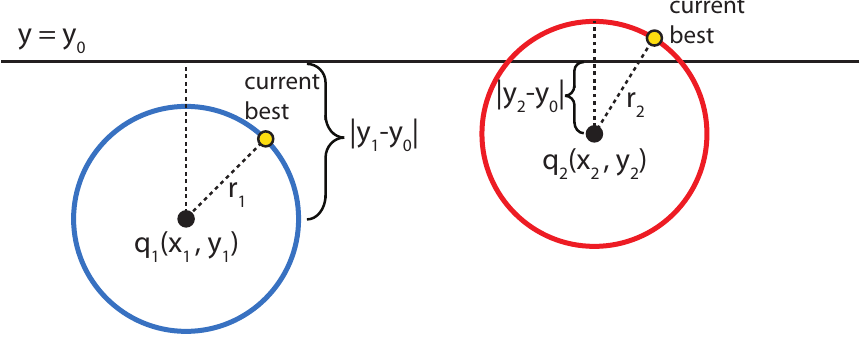
Figure 12. The left hyper-circle does not cross the hyper-line, but the right hyper-circle does cross the